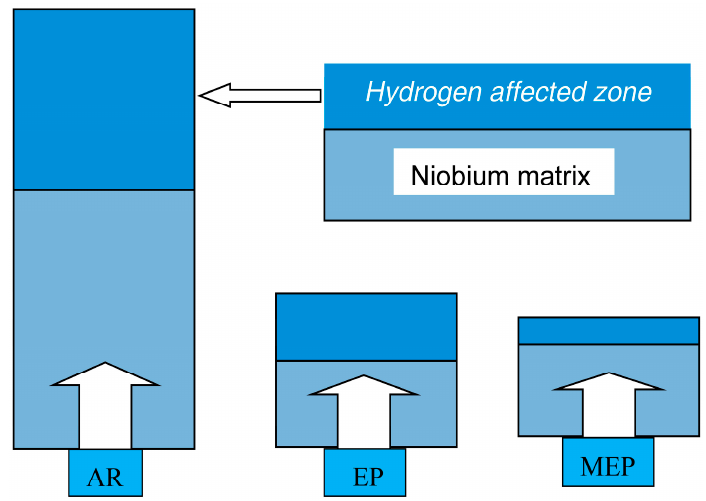
Figure 17. Comparable zone affected by hydrogen in Nb sample: AR—as received, EP—after electropolishing, MEP—after magnetoelectropolishing.